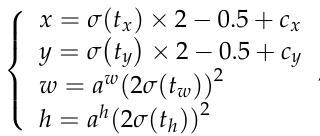
Figure 4. Structure of CBAM module.